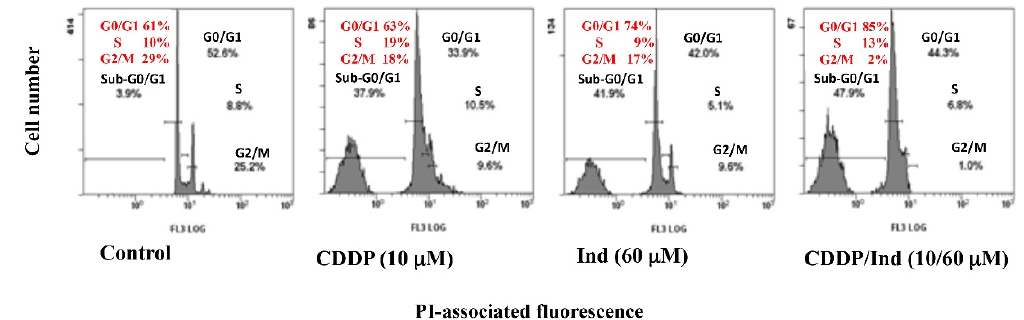
Figure 5. Effect of CDDP, Ind and CDPP/Ind combination on cell cycle distribution of HeLa cells. Cells were treated for 24 h as described in Methods. Then samples were submitted to flow cytometry analysis after propidium iodide (PI) staining and cell distribution compared to untreated cells (control). Each picture shows the percentage of viable cells in the different phases. Values are the mean ± SD of three separate experiments in triplicate. Representative images of three experiments with similar results.